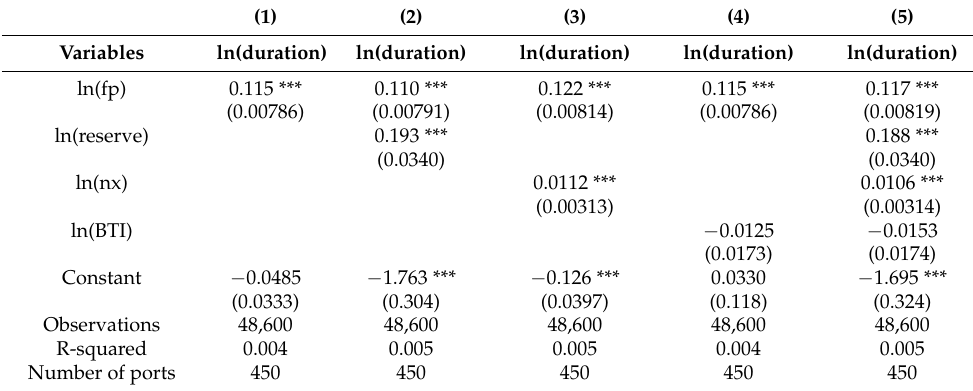
Table 8. Robustness test (duration): from 2011 to 2019.